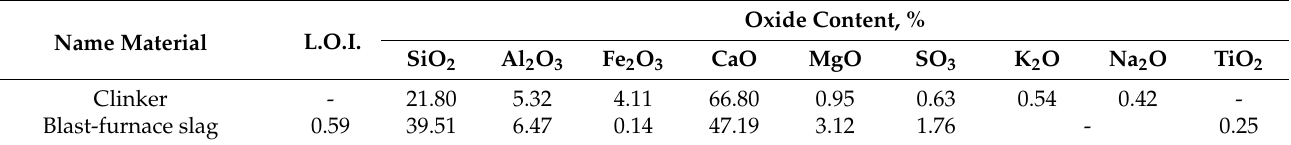
Table 2. Chemical composition of raw materials